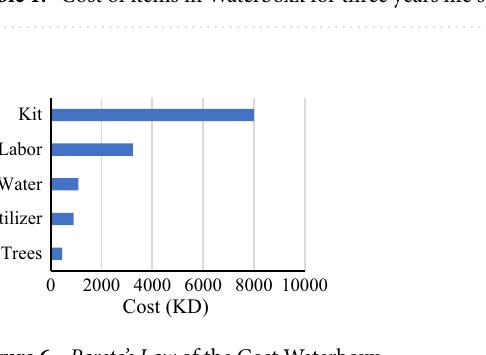
Table 1. Cost of items in Waterboxx for three years life span.